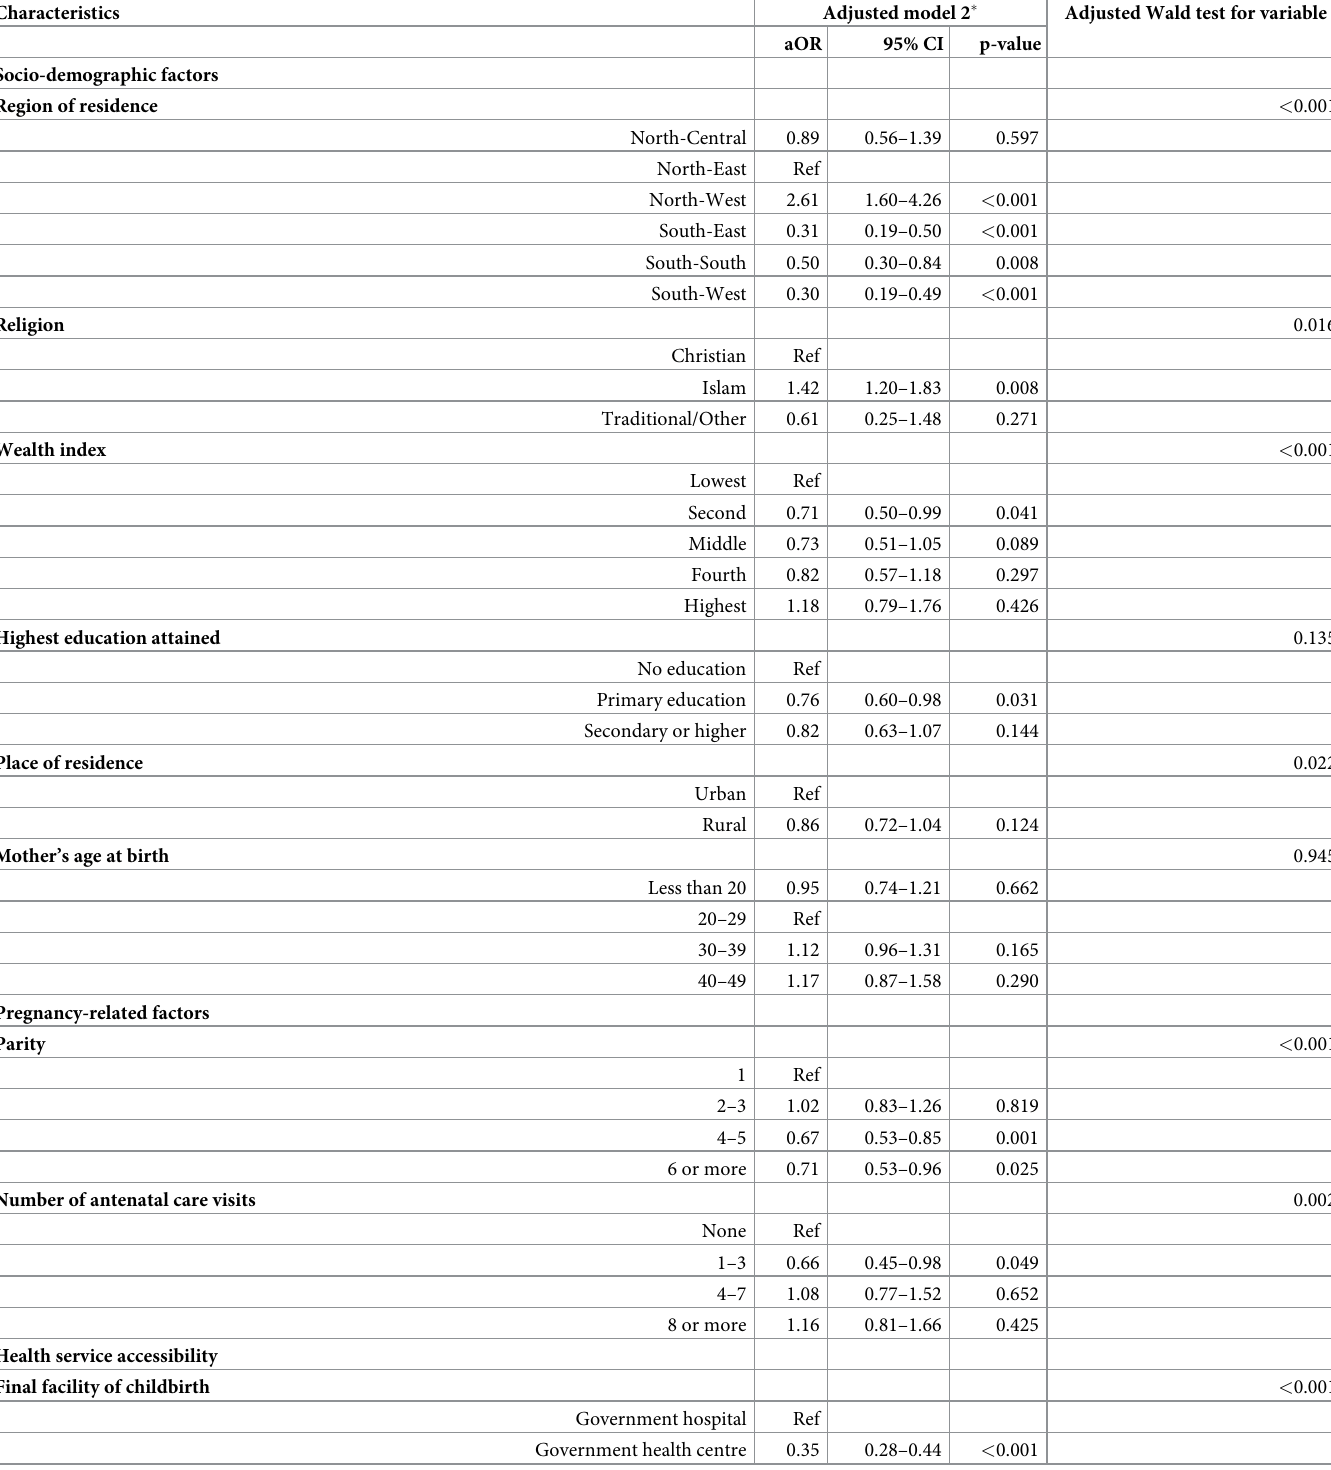
Table 4. Logistic regression model for use of motorised transport to place of childbirth as an outcome for all women whose most recent birth was in a health facility in the 2018 NDHS (N = 8,927).